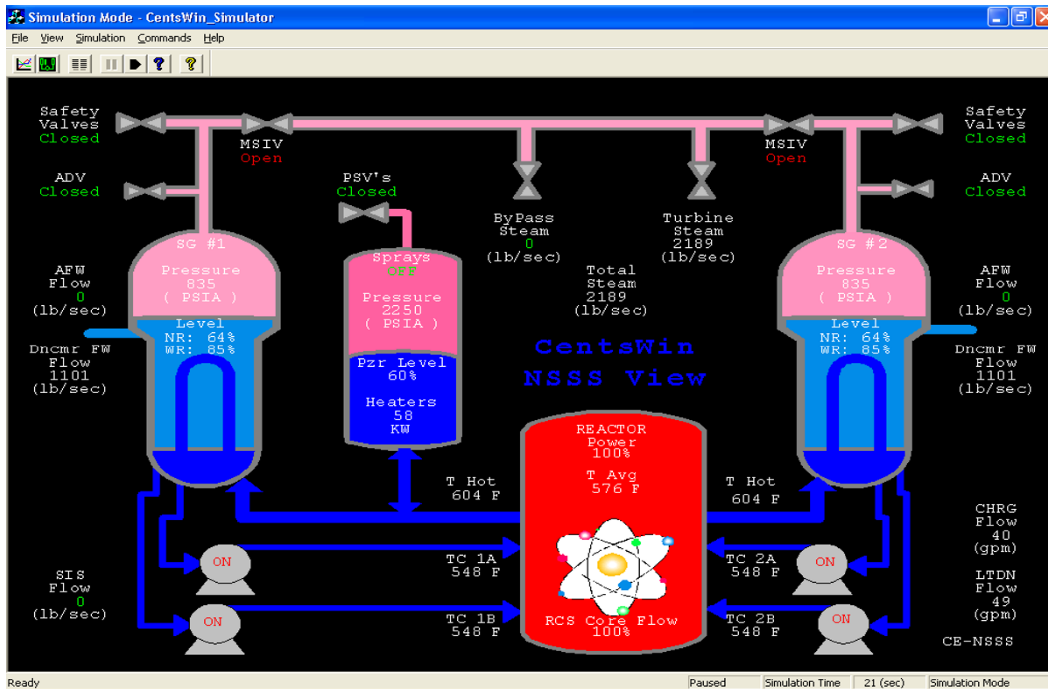
Figure 9. Graphical user interface of CENTS.